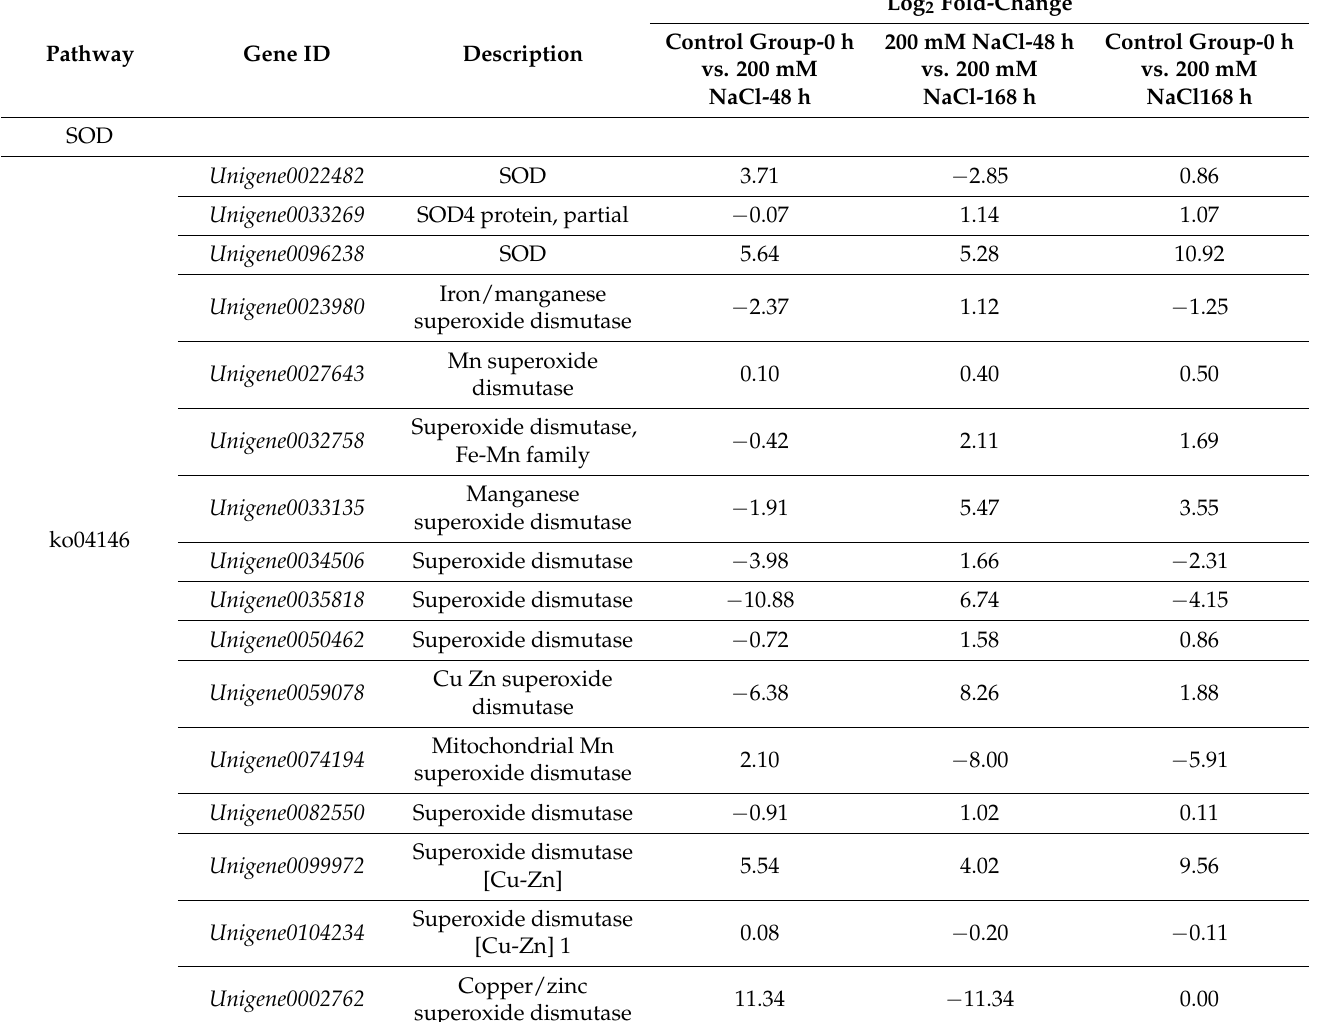
Table 1. Antioxidant enzyme activity differentially expressed genes annotated to KEGG pathway.